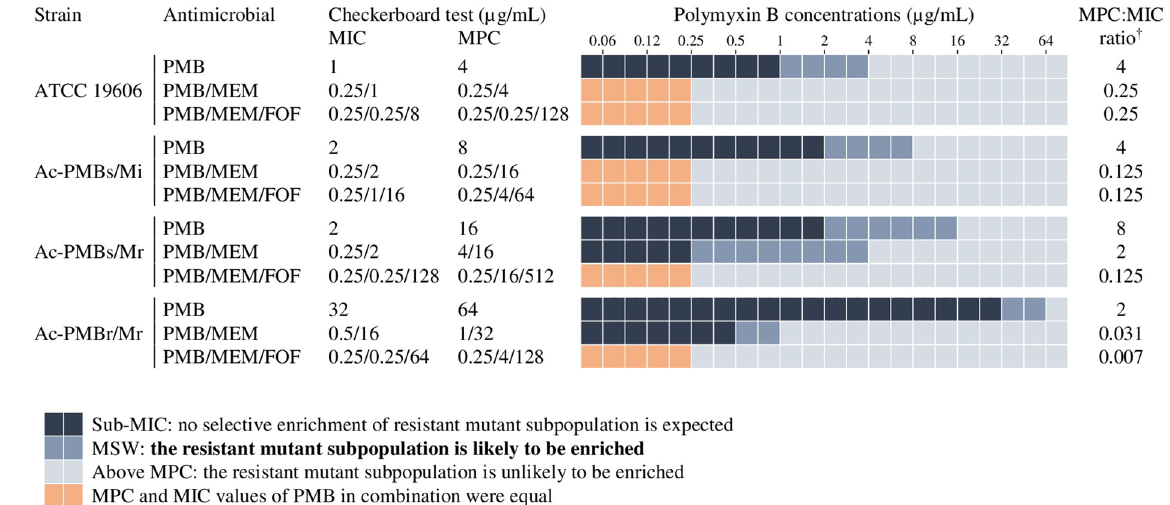
Figure 2. MIC, MPC, and MIC/MPC ratio of polymyxin B alone and in combination with meropenem and fosfomycin against A. baumannii strains. MIC minimum inhibitory concentration, MPC mutant prevention concentration, MSW mutant selection window, PMB polymyxin B, MEM meropenem, FOF fosfomycin, PMB/ MEM PMB combined with MEM, PMB/MEM/FOF the combination of all three antimicrobials. † MPC:MIC ratio is defined as the ratio of the MPC obtained to the original MIC and smaller values indicate a better ability to prevent the emergence of